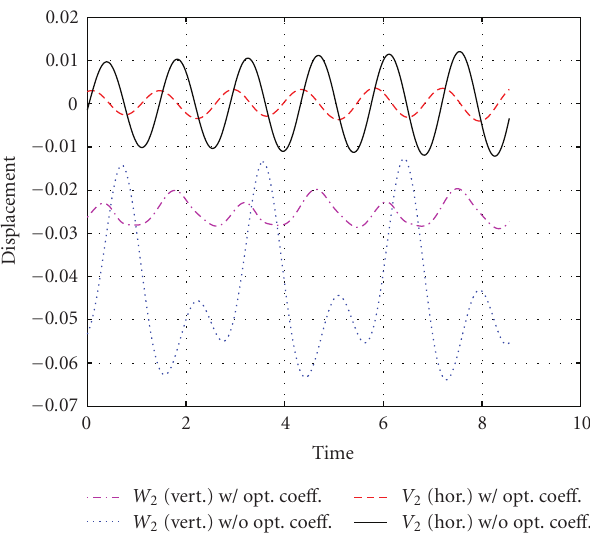
Figure 10: Response plots at Ω b = 2 . 2, bearing 2.